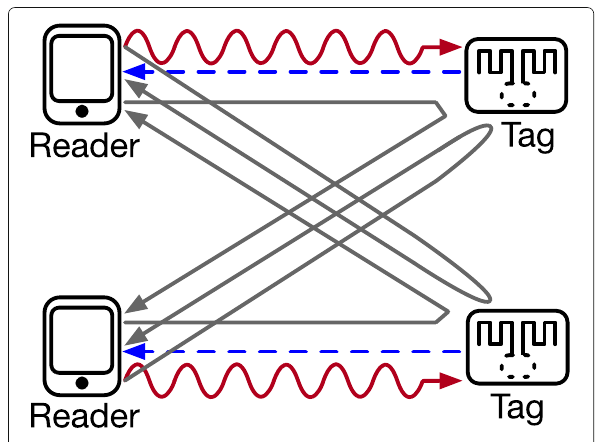
Fig. 6 BackCom interference network